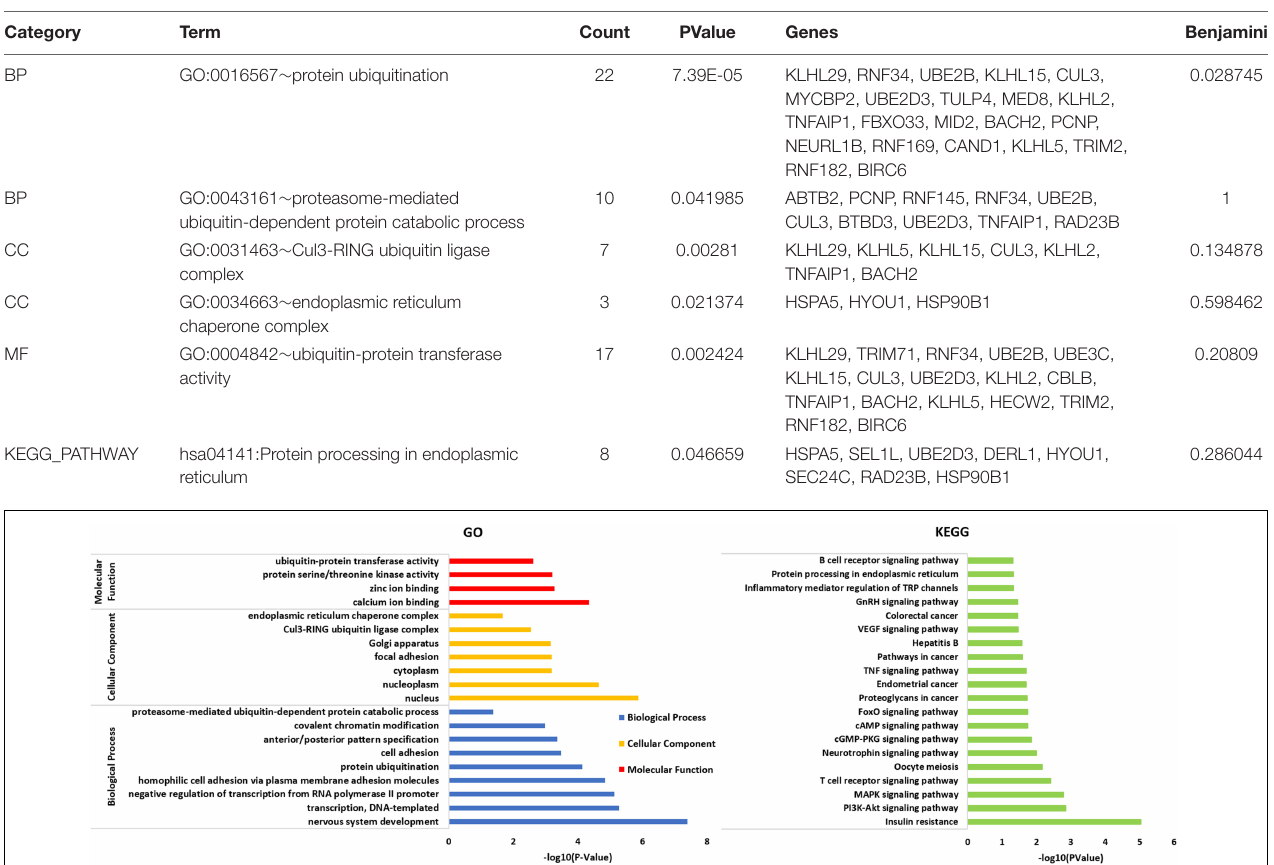
TABLE 1 | 36 genes are particularly enriched in protein ubiquitination and endoplasmic reticulum chaperone complex involved in ubiquitin-dependent protein catabolic process. Category